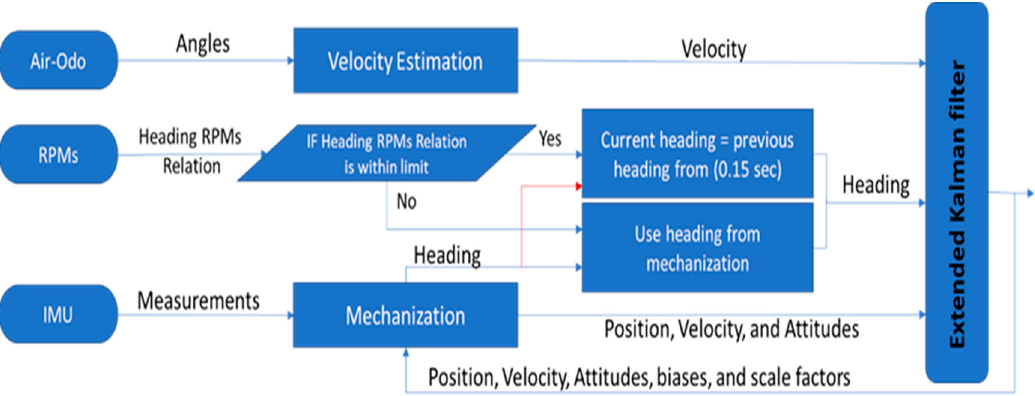
Figure 5. Proposed approach workflow and Air-Odo/vehicle dynamic model/INS integration, through an EKF scheme.